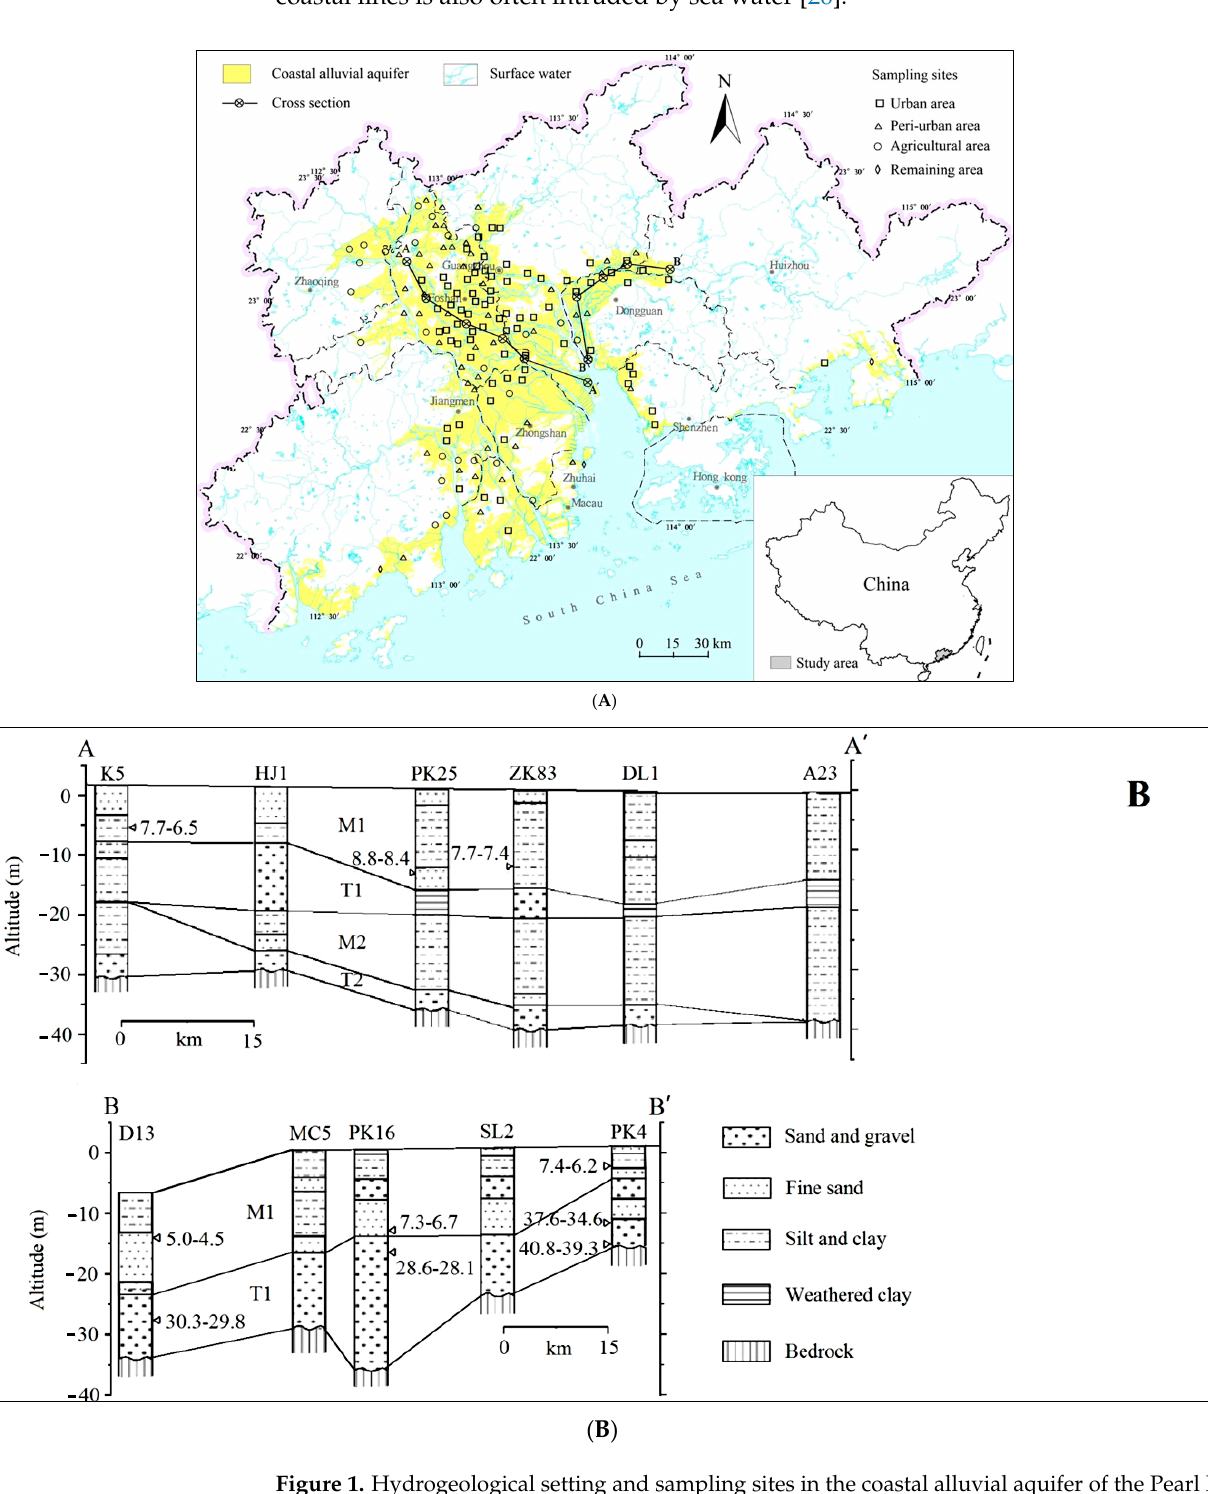
Figure 1. Hydrogeological setting and sampling sites in the coastal alluvial aquifer of the Pearl River Delta. ( A ) Sampling sites. ( B ) Cross sections.